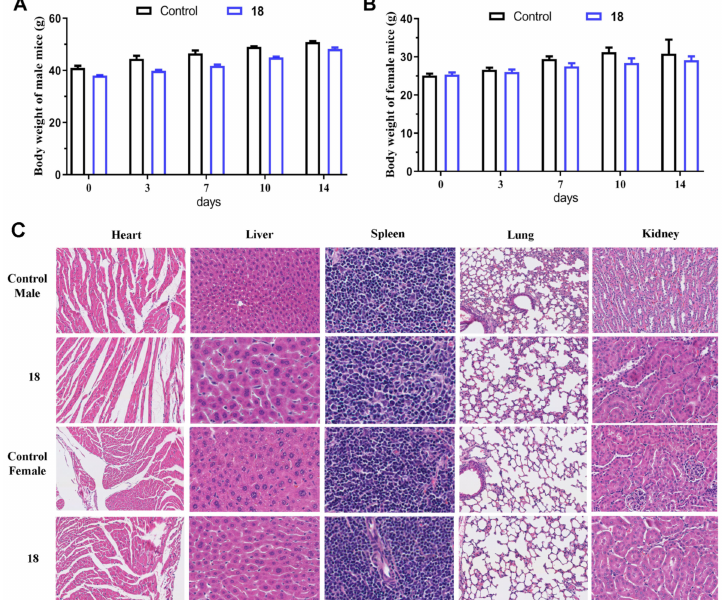
Figure 6. The safety evaluation of compound 18 . ( A ) Body weight of male mice-time; ( B ) Body weight of female mice-time; ( C ) The histological changes in mice were analyzed by HE staining (magnification: ×